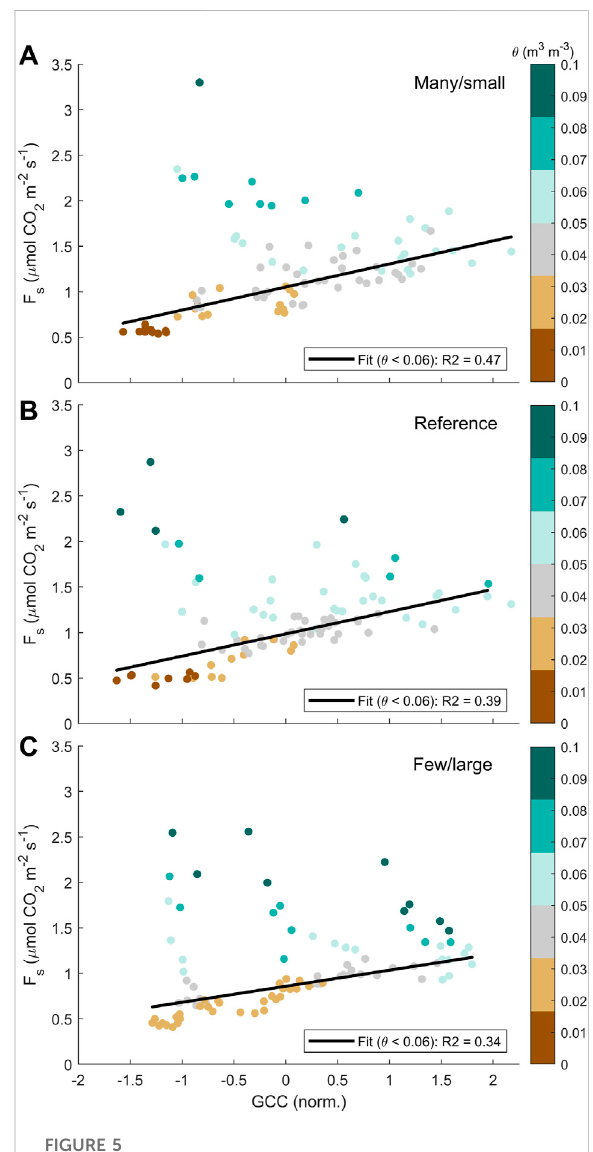
FIGURE 5 Response of daily mean soil CO 2 ef fl ux (F s ) to normalized anomalies in green chromatic coordinate (GCC) colored by soil moisture ( θ ) for the three levels of rainfall repackaging. The regressionline isonly fi tto low soilmoisturevalues( θ <